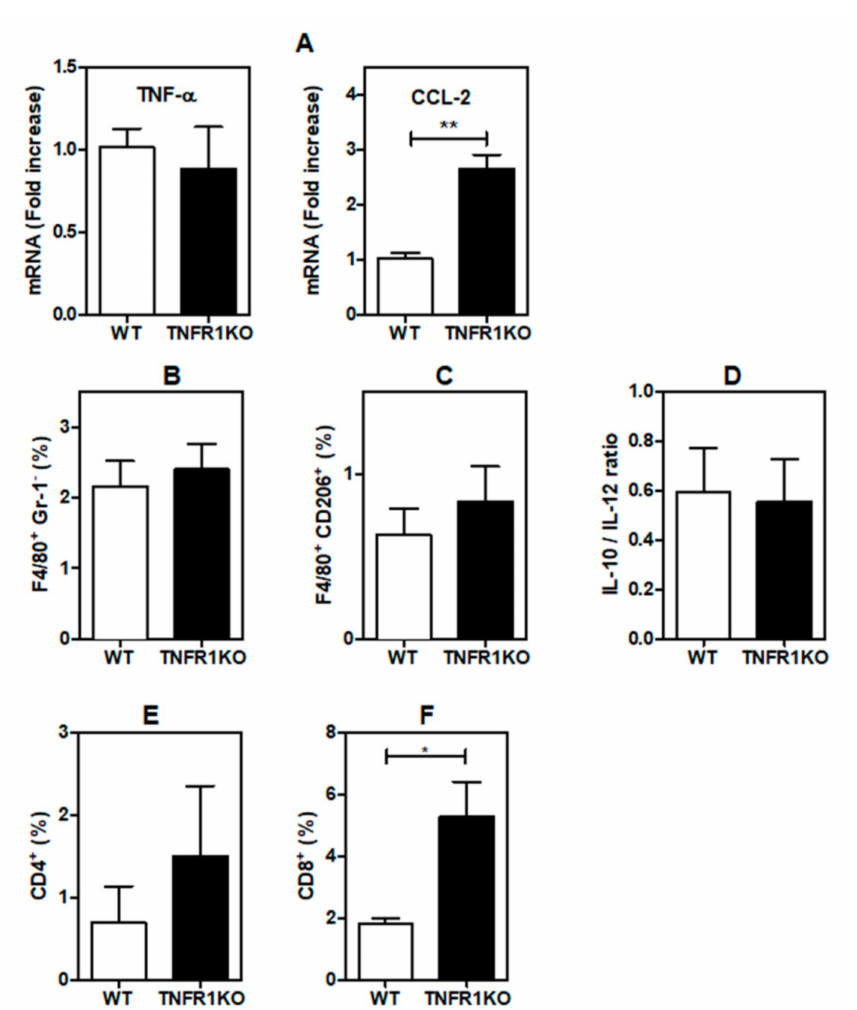
Figure 6. TNFR1 di ff erentially controls immune cell infiltrates in the tumor microenvironment.TNFR1 KO and WT animals were inoculated with B16.F1 cells and analyzed for: ( A ) Expression of TNF- α and CCL-2 in tumor tissue. ( B ) Percentage of total TAMs. ( C ) Percentage of M2-polarized TAMs. ( E ) Frequency of CD4 + T cells and ( F ) CD8 + T cells in tumor tissue by flow cytometry. ( D ) Ratio of IL-10 and IL-12 concentrations by ELISA. Samples were obtained and analyzed at day 19 post-inoculation. The results are shown as the mean ± SEM of 3 independent experiments, * p < 0.05, ** p <